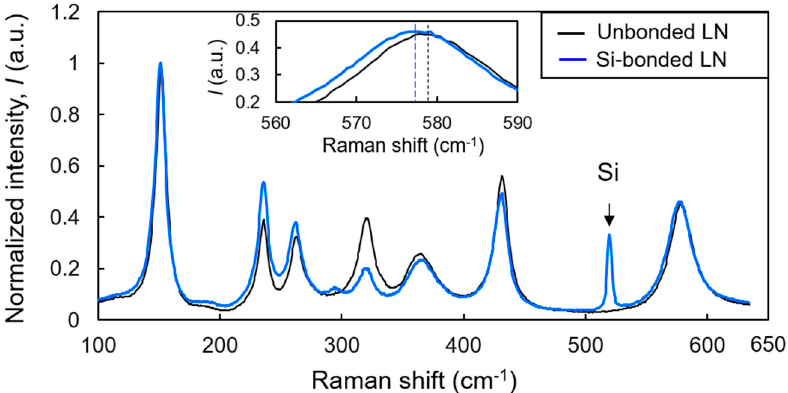
Figure 4. Raman spectra of unbonded LN and Si-bonded LN. Intensity is normalized to the maximum intensity of the 152 cm − 1 line. Enlarged spectra around 578 cm − 1 are shown in the inset, where the peak positions are depicted by dashed lines.